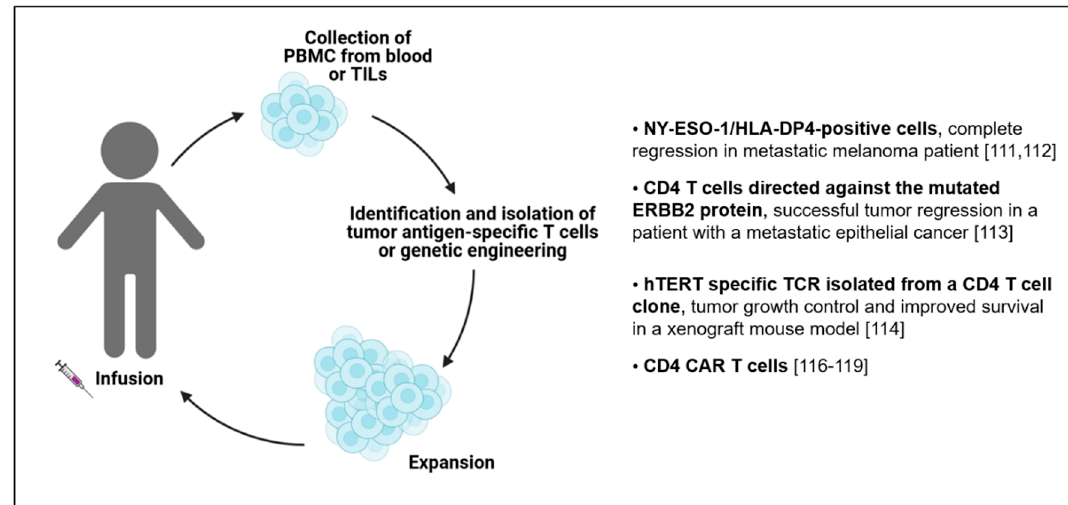
Figure 4. Summary of ACT therapies exploiting CD4 T cells.